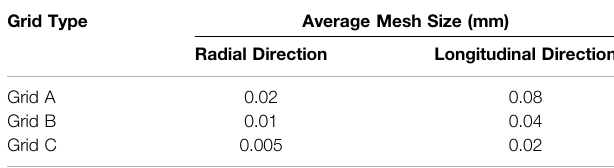
TABLE 4 | Dimensions of mesh cells in different mesh